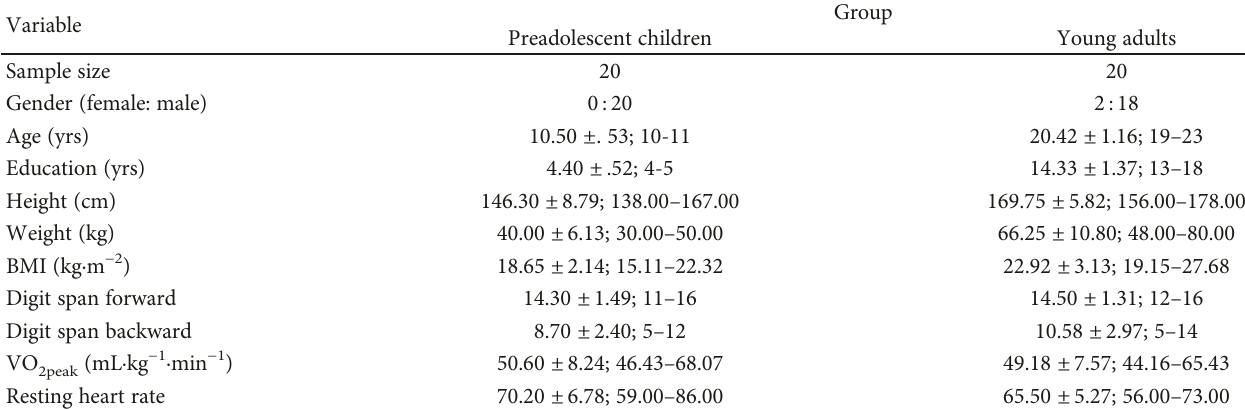
Table 1: Participant demographic characteristics (mean ± 1 SD;